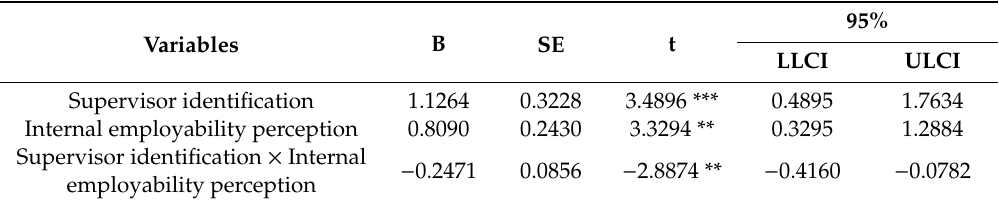
Table 4. Results of the moderating e ff ect of internal employability perception in the relationship between supervisor identification and unethical pro-supervisor behaviors (UPSB).